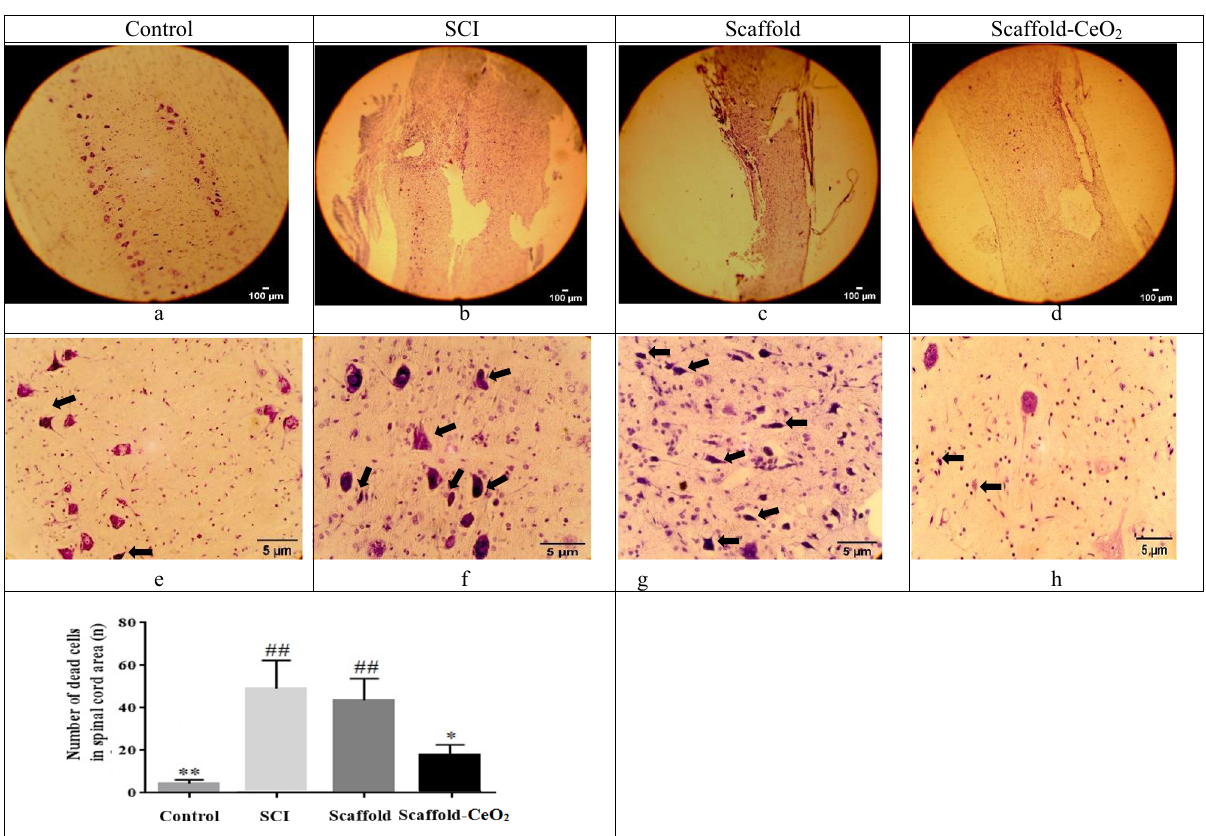
Fig. 4 Nissl staining. a The normal structure of the spinal cord in the control group and ( b ) Signi fi cant structural changes in SCI group. An improvement is observed in structure of spinal cord in ( c ) Scaffold group and more better structure is observed in ( d ) Scaffold-CeO 2 Group. Nissl bodies is observed in ( e ) very low number in Control group and ( f ) the loss of nerve cells and the emergence of Nissl bodies